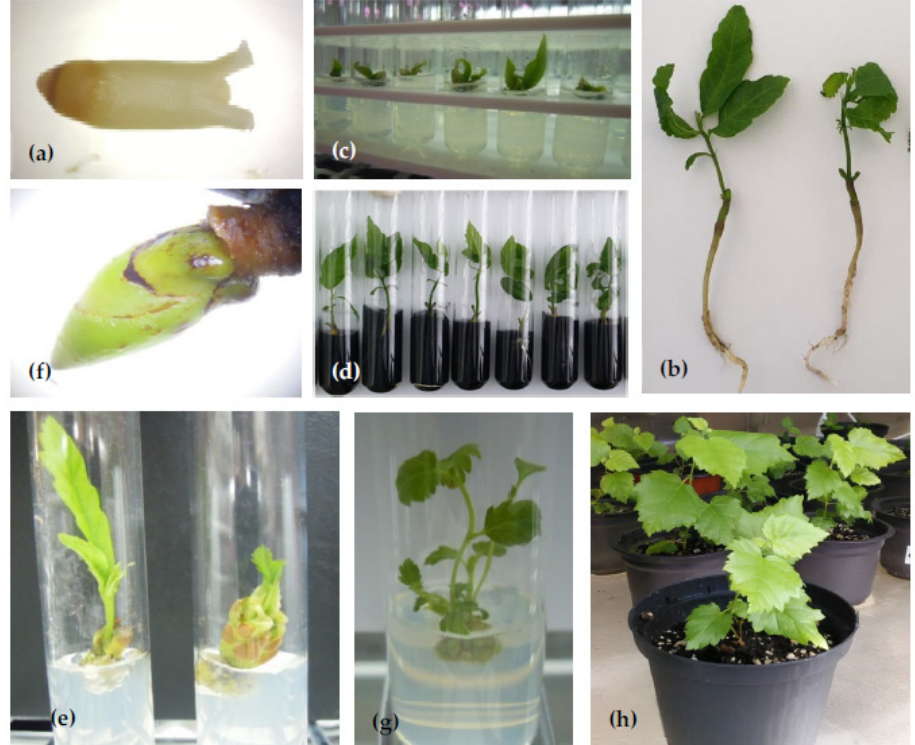
Figure 1. Micropropagation of selected woody plants. ( a ) Embryonic axes of Castanea sativa ; ( b ) rooted Castanea sativa shoots after 6 weeks of culture in WPM supplemented with 0.4µM N6-6-benzylaminopurine (BAP) and 15 µM indole-3-butyric acid (IBA); ( c ) Castanea sativa bud culture in WPM; ( d ) embryonic axes of Castanea sativa cultured in WPM supplemented with 0.3% AC; ( e ) in vitro development of Quercus hartwissiana on WPM supplemented with 2.5 µM BAP after 28 days of culture; ( f ) buds of Betula megrelica ; ( g ) multiplication stage of Betula spp. initiated in MS medium supplemented with 4.4 µM BAP; and ( h ) potted plantlets of Betula spp. 6 weeks after potting and acclimatization in a greenhouse.